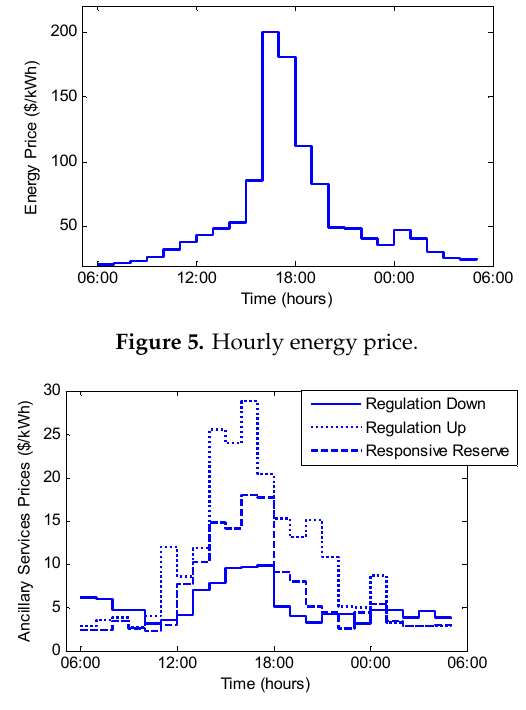
Figure 6. Hourly ancillary services prices.